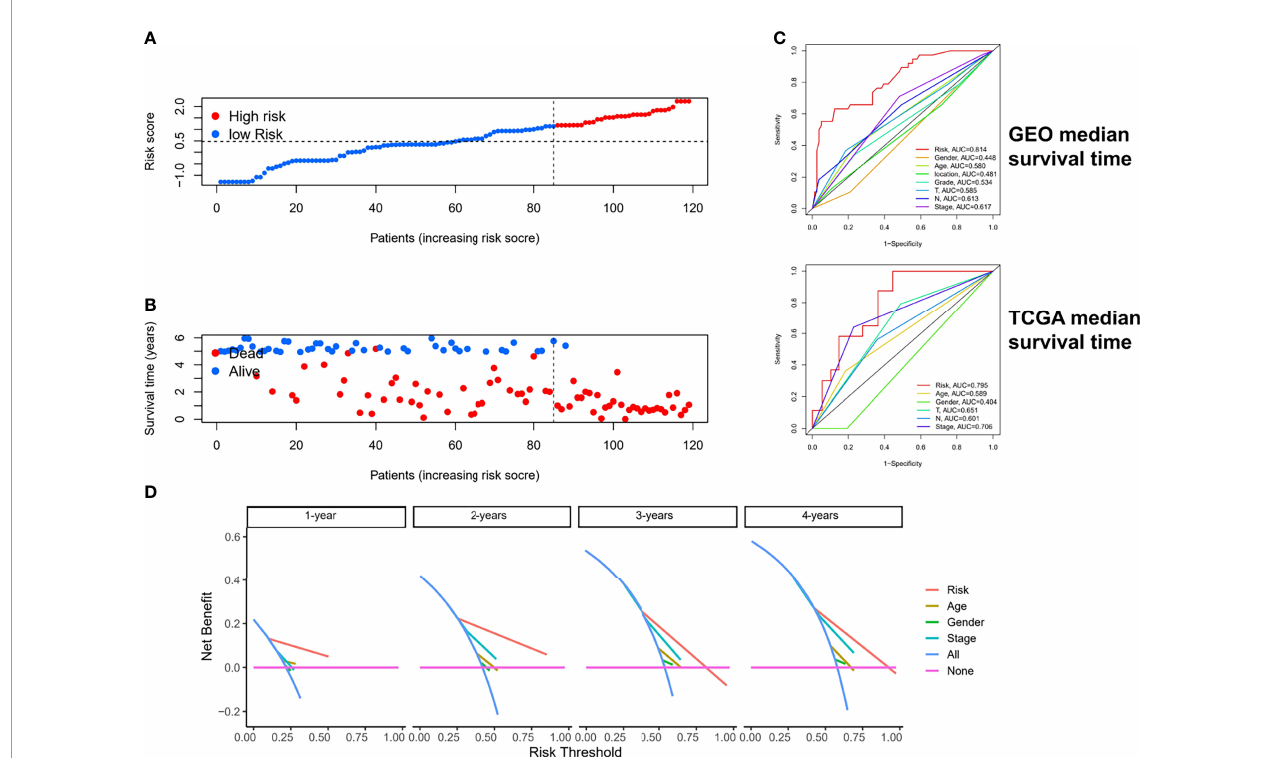
FIGURE 6 | Estimation of clinical value of ER-lncRNA pairs risk-score model in ESCC patients. (A) Risk score distribution plot showed the distribution of high-risk and low-risk ESCC patients. (B) Scatter plot showed the correlation between the survival status and risk score of ESCC patients. (C) ROC curve analysis showed the prognostic accuracy of risk score and clinicopathological parameters. (D) Decision curve analysis